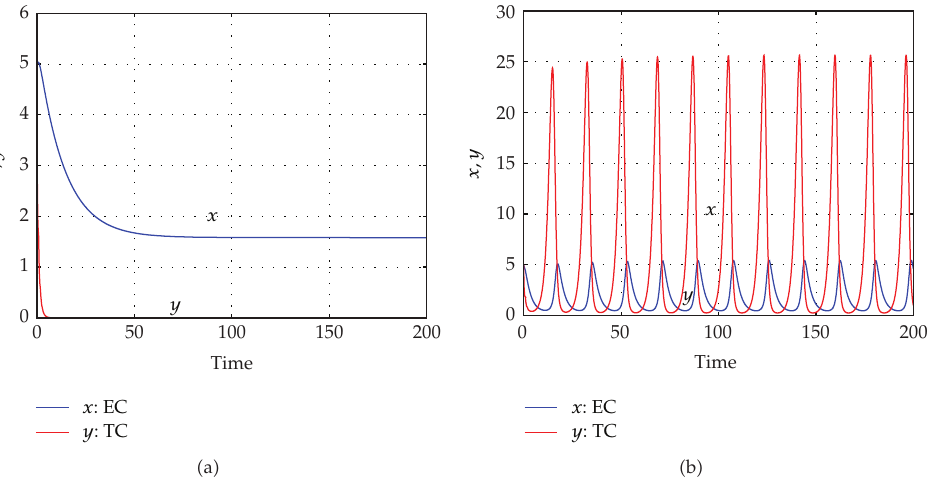
Figure 3: Solution of the DDEs (cid:4) 2.7 (cid:5) when ω (cid:8) 0 . 04184, μ (cid:8) 0 . 03747 (cid:4) a (cid:5) , and μ (cid:8) 0 . 3747 (cid:4) b (cid:5) , s (cid:8) 0 . 2181, r (cid:8) 1 . 636, b (cid:8) 0 . 002, and τ (cid:8) 0 . 8. The tumor-free equilibrium is asymptotically stable in the left banner and unstable in the right